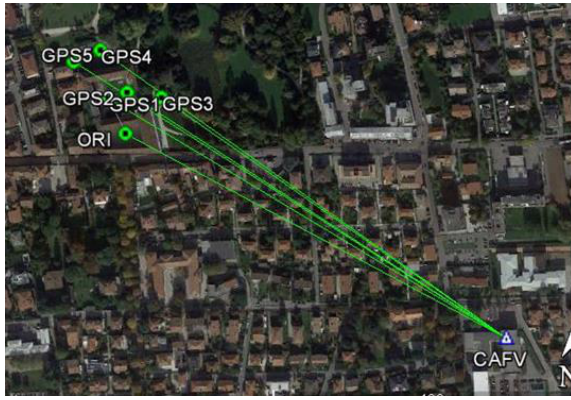
Figure 14: Baselines between observed GCPs and the local permanent station of the Leica ITALPOS GNSS network